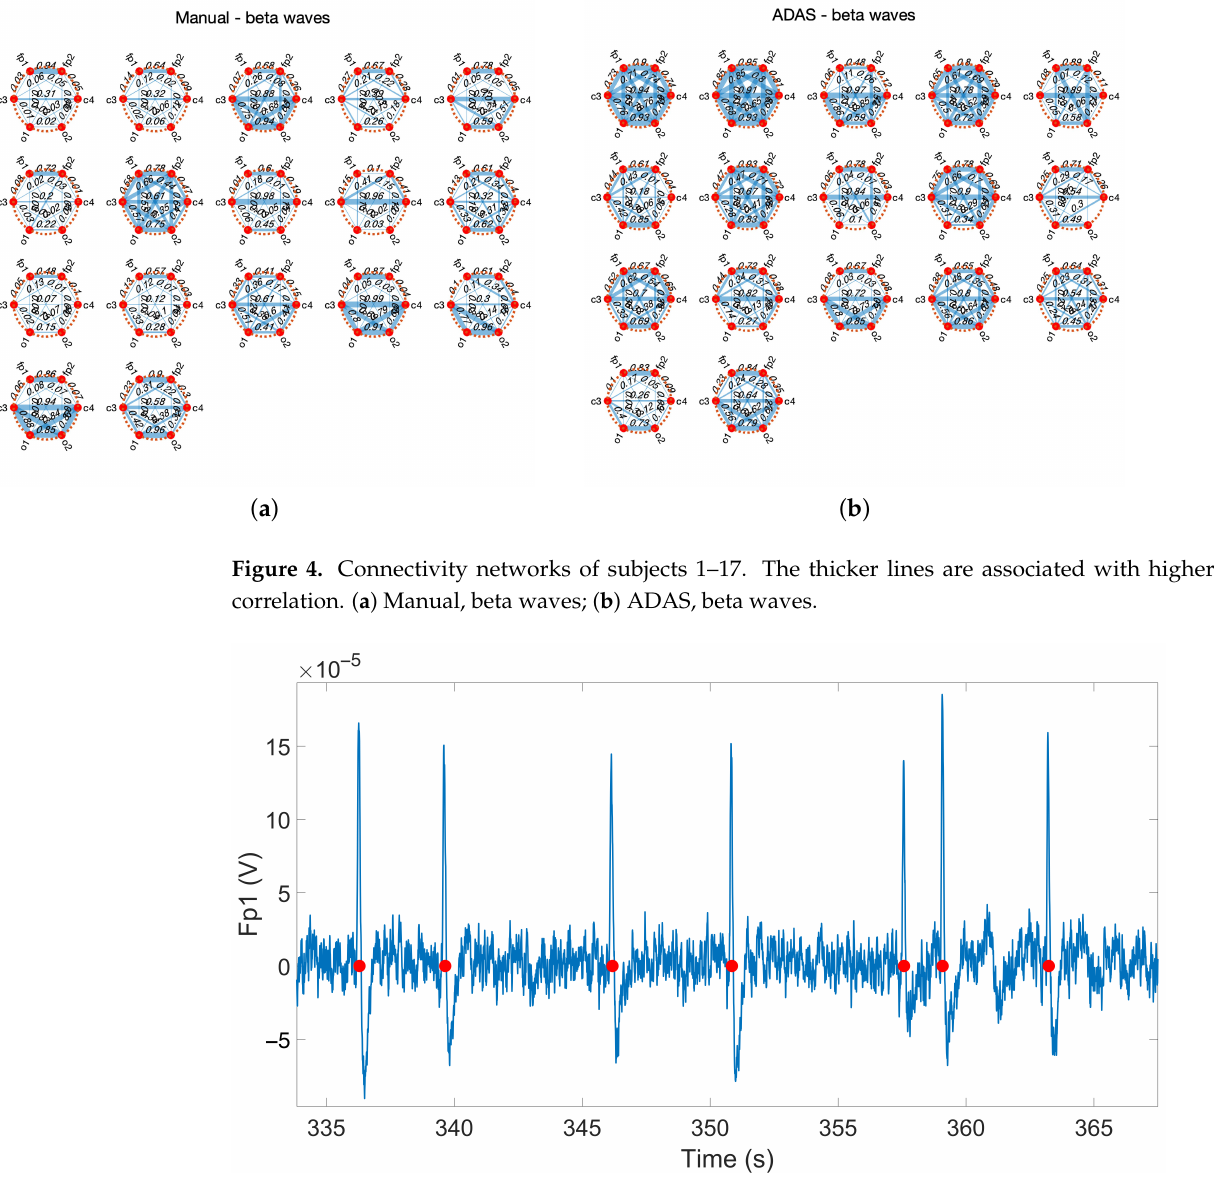
Figure 5. Example of EEG signal in Fp1 location (blue line) and blink identification by Blinker (red